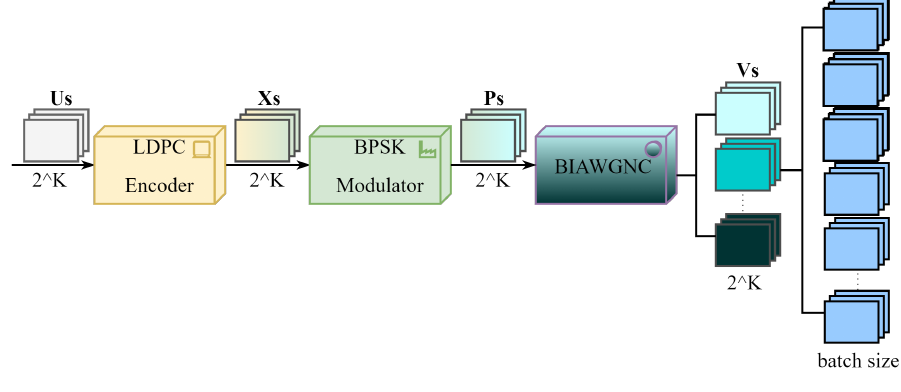
Figure 8. Specific process of data set generation.